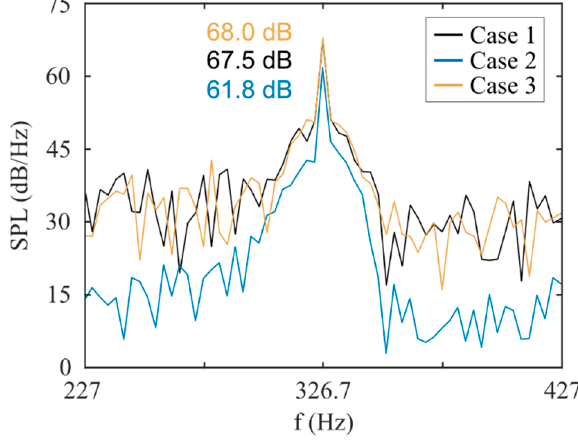
Figure 10. SPL of the sound upstream of the fan. The tonal frequency 𝐵𝑃𝐹 = 326.7 Hz. The cases are compared for their aerodynamic and acoustic performance in Table 3. Table 3. Aerodynamic and acoustic performance.